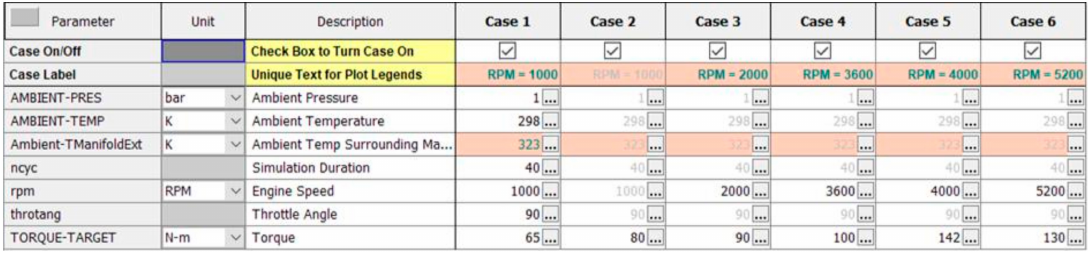
Table 1. Case setup for the engine model.